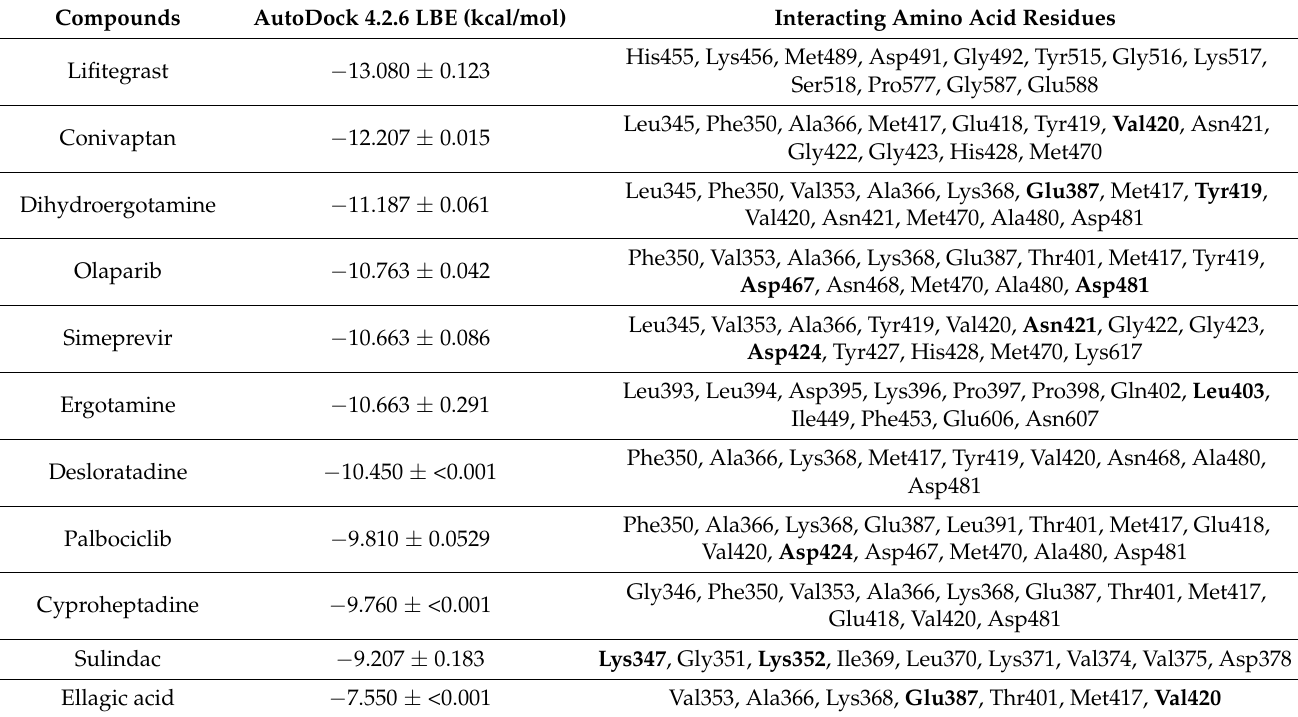
Table 2. In silico screening of FDA-approved drugs binding to PRKCA. Shown are the top 10 out of 1577 tested drugs. The amino acid residues in bold formed hydrogen